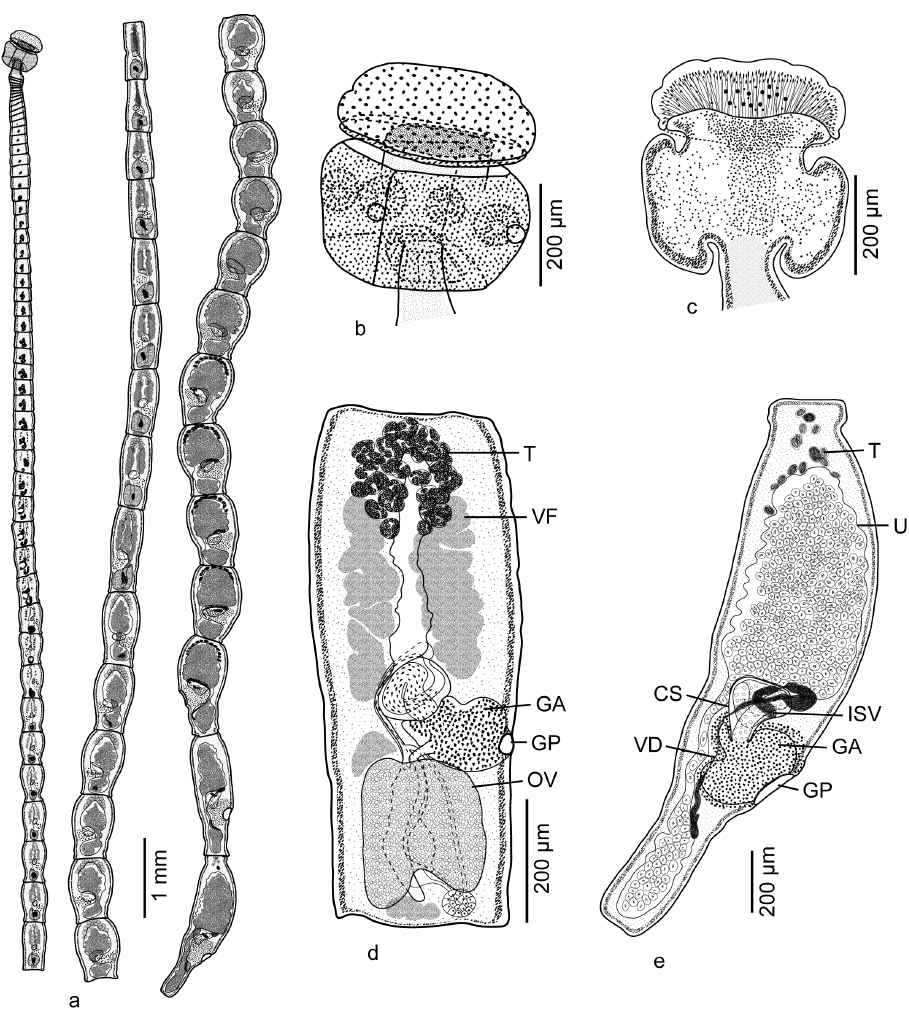
Figure 2. Line drawings of T. salarii sp. n. from H. randalli . a Whole worm b Whole structure of scolex c Internal details of scolex d Mature proglottid e Gravid proglottid. Abbreviations: CS, Cirrus Sac; GA, Genital Atrium; GP, Genital Pore; ISV, Internal Seminal Vesicle; T, Testis; OV, Ovary; U, Uterus; VD, Vas Deferens; VF, vitelline follicle. line from ootype to genital atrium, opening into genital atrium posterior to cirrus sac; vaginal sphincter absent. Genital pores lateral, irregularly alternating, 30−36% (33; 4; 8) of proglottid length from posterior end. Genital atrium massive, conspicuous. Uterus bisaccate, extending along median line of proglottid from posterior margin of ovary to anterior margin of proglottid, constricted at level of genital atrium; uterine duct entering uterus at level of posterior margin of genital atrium. Vitellarium follicu- lar; vitelline follicles medullary, 38−48 (44; 4; 24) long by 57−69 (65; 4; 24) wide,